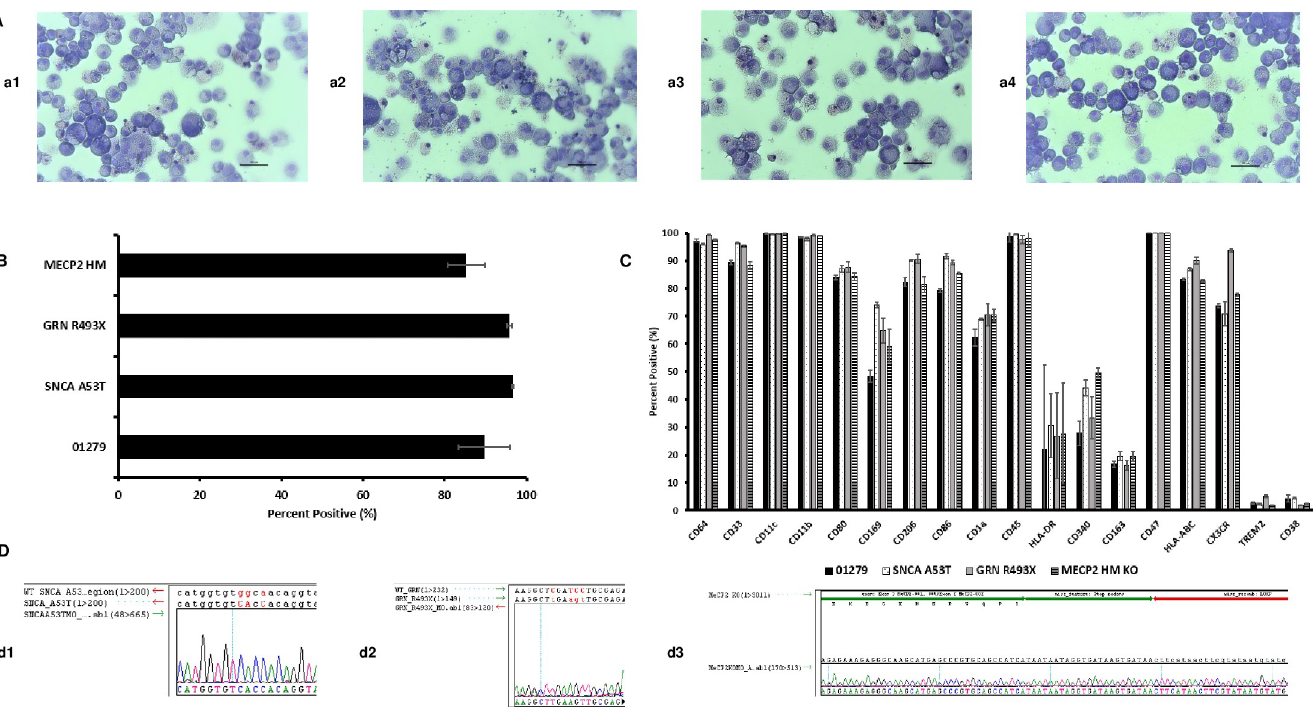
Fig 4. Functional characterization and sequencing of macrophages from isogenic iPSC for disease modelling. (A) Morphological analysis post thaw was performed by staining the cultures using wright stain (a1) 01279, (a2) SNCA A53T, (a3) GRN R493X), and (a4) MECP2 HM. All pictures captured at 20X objective. (B) Quantification of CD68 expression post thaw by flow cytometry. The graphs depict an average of 3 samples ± SE. (C) Additional characterization of the macrophages by staining cells for the presence of CD64, CD33, CD11c, CD11b, CD80, CD169, CD206, CD86, CD1a, CD45, CD340, CD163, CD47, HLA-ABC, CX3CR, TREM2, and CD38 expression by flow cytometry. The graphs depict and average of 3 samples ± SE. (D) Sequence confirmation of genetically engineered iPSC Derived macrophage. (d1) SNCA A53T macrophage sequence (d2) GRN R493X macrophage sequence (d3) MeCP2 HM KO macrophage sequence. Alignment was performed to the wildtype sequence (WT) and appropriate expected mutation sequence for d1 and d2. The alignment was performed to the expected inserted sequence alone for MeCP2 HM (d3).